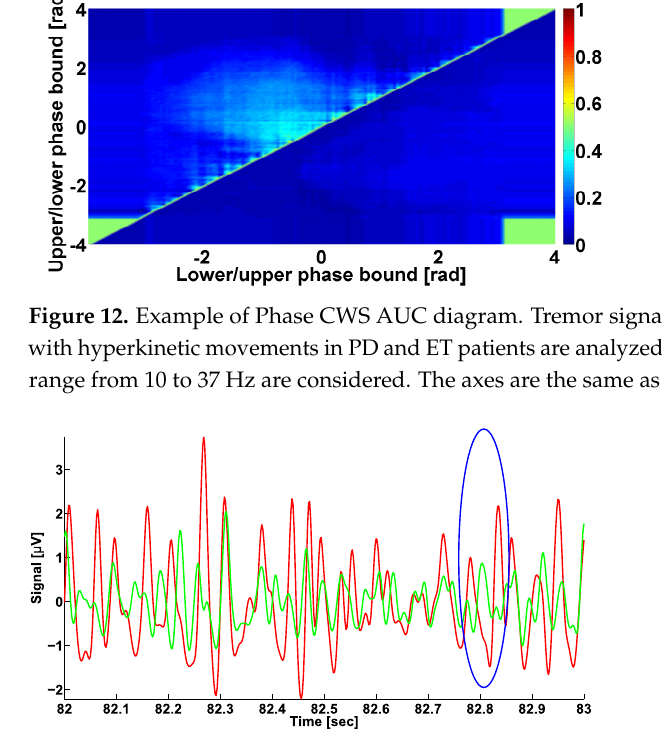
Figure 13. Example of the cross-wave train in frequency range from 10 to 37 Hz. Envelopes of EMG signals in antagonist muscles of left arm with hyperkinetic movements in ET patient are demonstrated. The signals from the flexor and extensor muscles are indicated in green and red, respectively. Cross-wave train is indicated by a blue ellipse and has the following characteristics: central frequency is 16.6 Hz, PSD is 0.69 µ V 2 / Hz, duration is 1.59 periods, frequency bandwidth is 4.3 Hz, and instantaneous phase is − 2.14 radians. Abscissa axis indicates the time in seconds. Ordinate axis indicates the envelope of the signal in µ